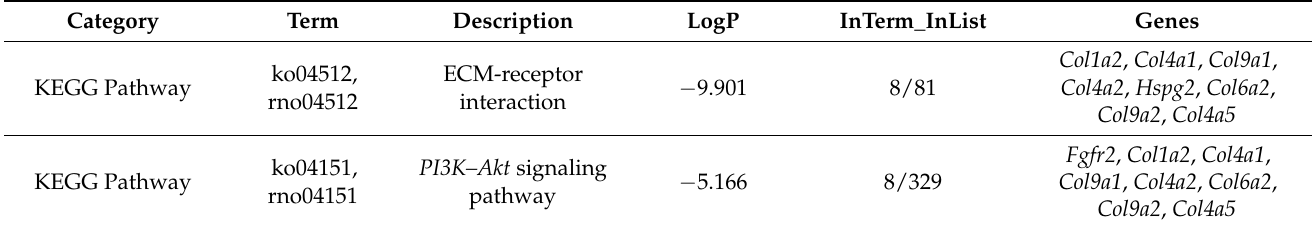
Top KEGG pathways significantly enriched in DEGs related to anti-apoptosis in NK-5962-treated retinas